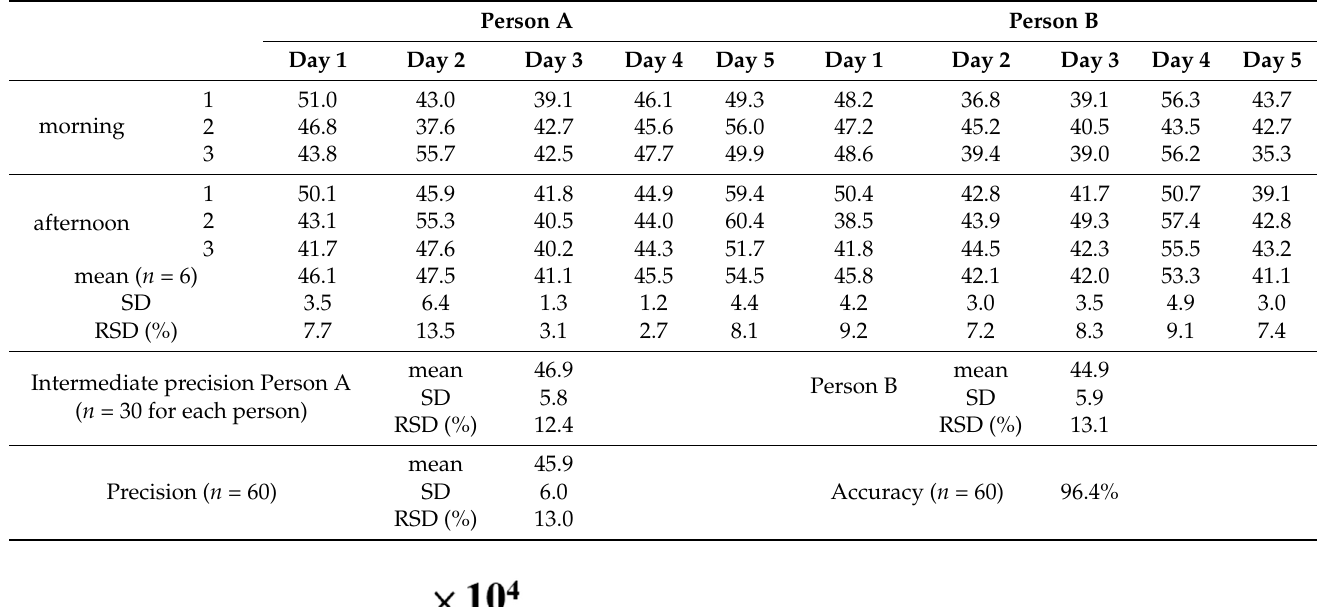
Table 1. Evaluation of the precision and accuracy of the developed method.